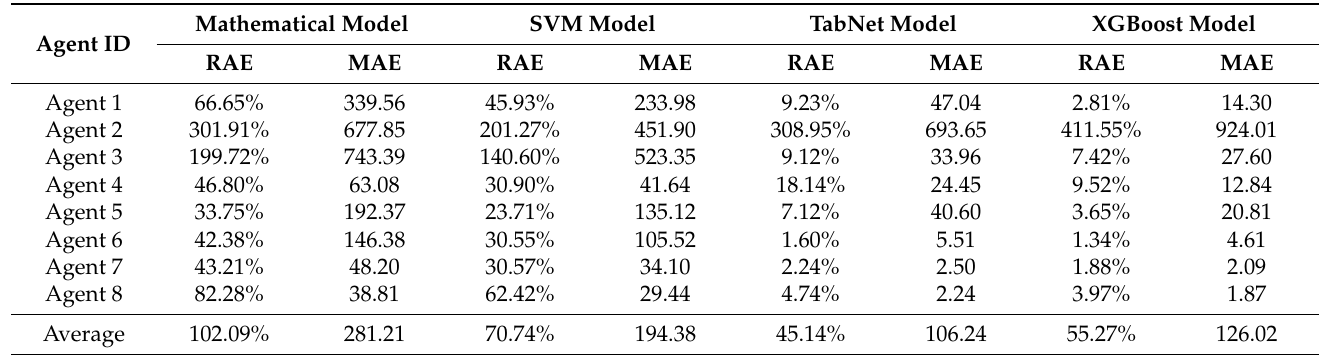
Table 4. Energy forecast